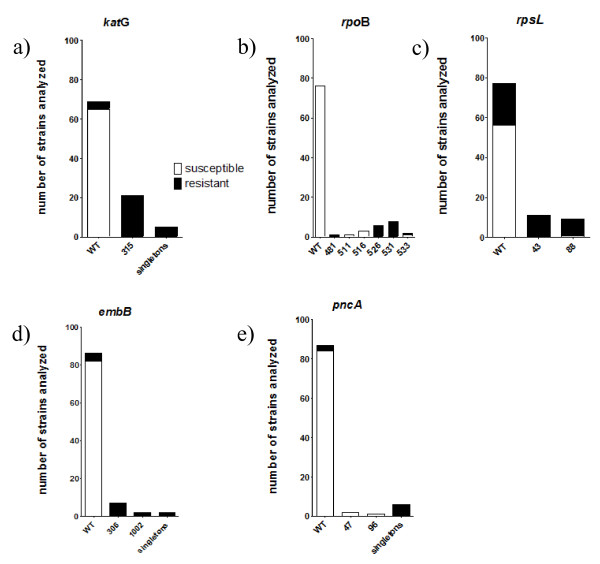
Overview of mutations detected in all strains analyzed in a)katG, b)rpoB, c)rpsL, d)embB and e)pncA. The height of the columns represent the number of strains analyzed. On the x-axis the different mutated codons are shown. The white areas of the columns represent the fraction of susceptible strains, whereas the black areas correspond to the number of resistant strains. Abbreviations: WT, wild type; singletons, various codons that are affected in one strain only.